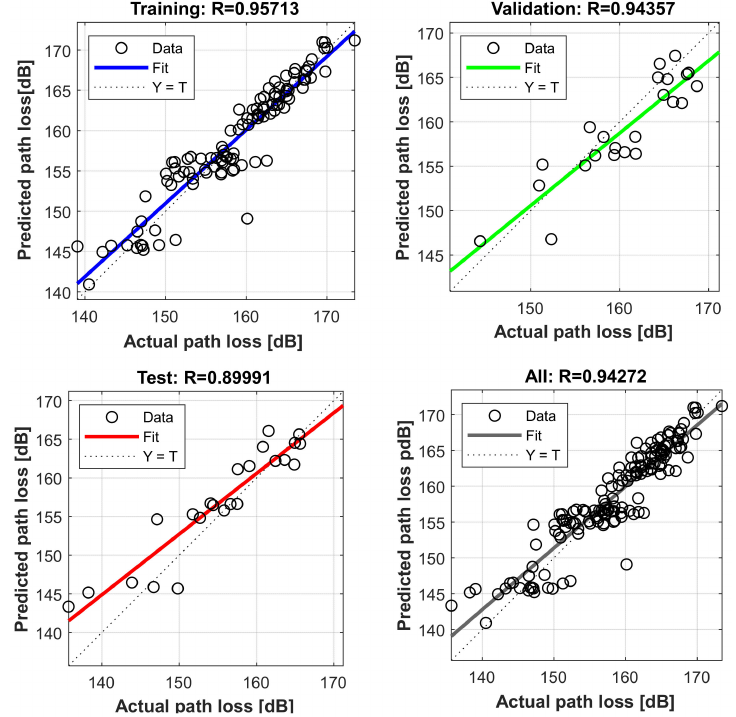
Figure 12. Prediction performance with correlation coefficient in site